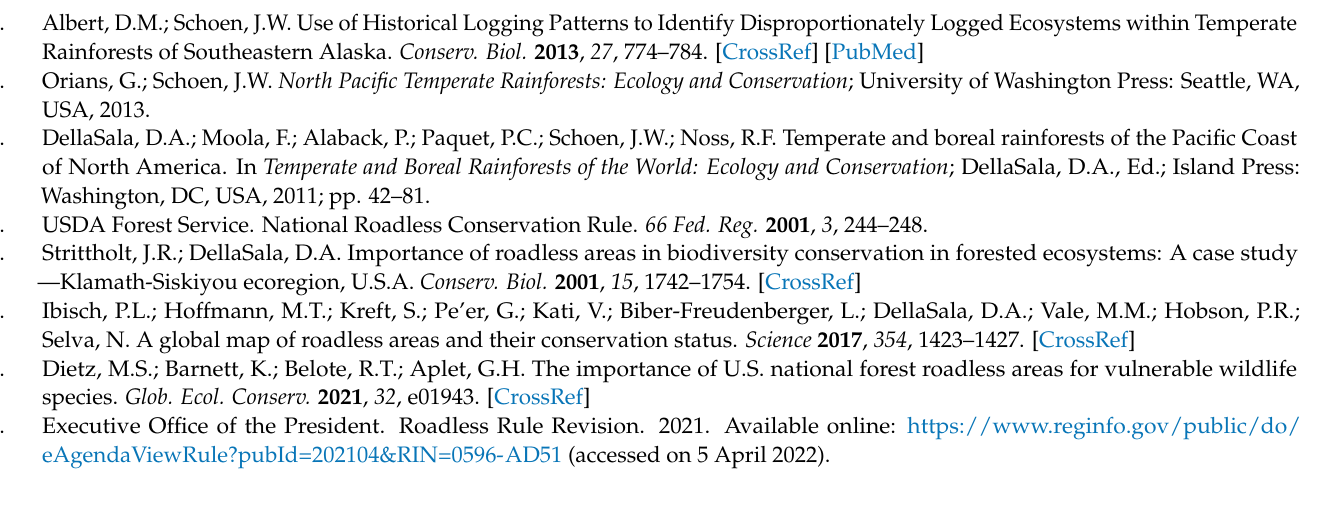
3. Figure S3: Spatial distribution of T77 watersheds and total carbon (metric tons ha − 1 ) in woody plant biomass and soil pools combined. Figure S4: Committed 100-year emissions from both Tongass and Chugach National Forest timber harvests (1910–2013). Comparison of our study with prior research. Table S1: Carbon datasets used in this study. Table S2: Historic (1909–2021) and projected (2022–2100) harvest levels (thousand cubic meters per year, 1 × 10 3 m 3 yr − 1 ), committed